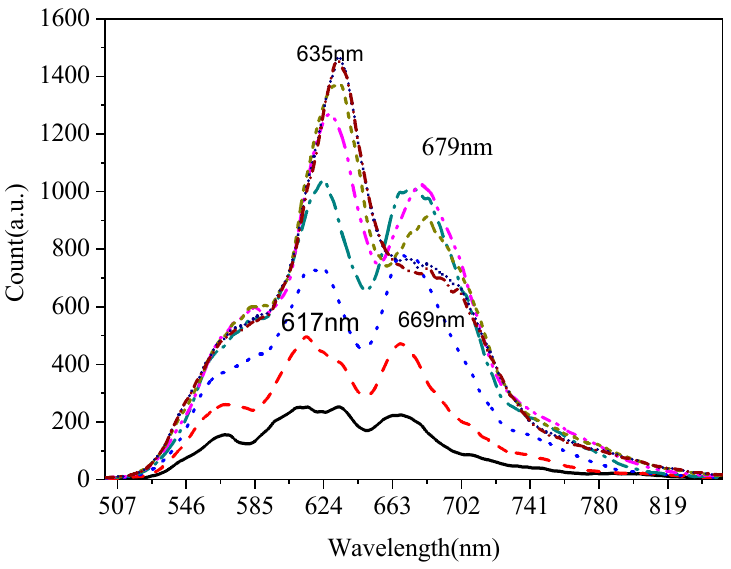
Figure 11. Emission spectra of the Yb 2+ -doped silica fiber as a function of the angle between fiber face and laser cavity mirror at an excitation of 405 nm.